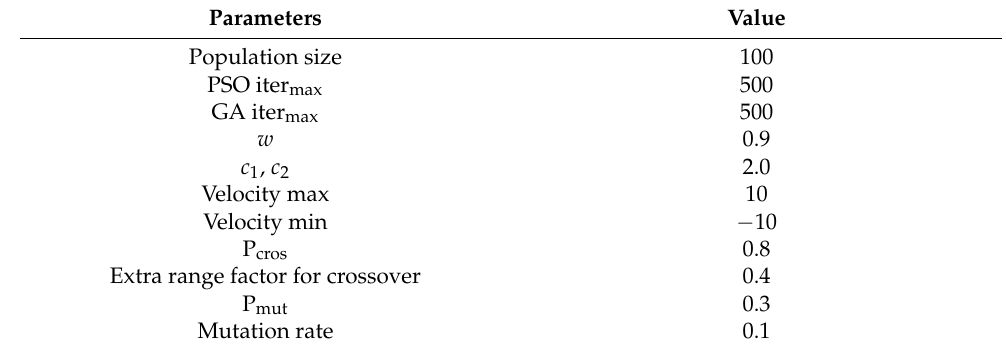
Table 6. PSO-GA parameters.